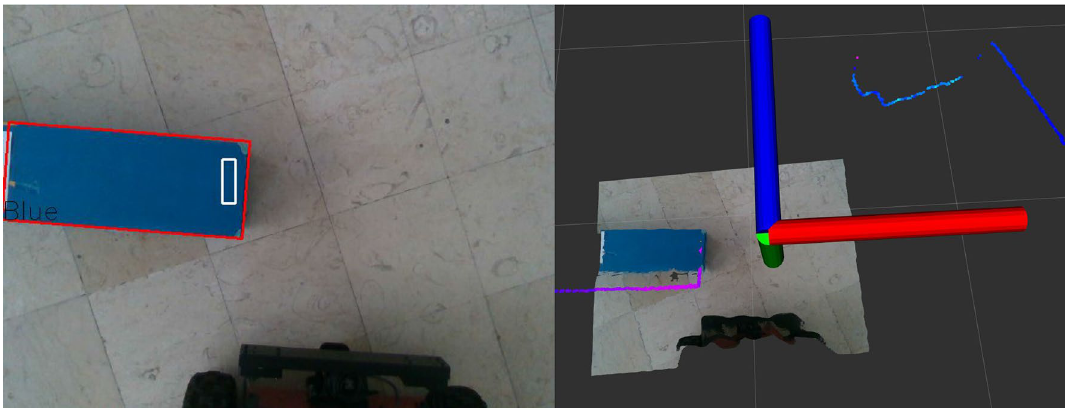
position for the edge of the reference brick. Right: A placement pose is computed relative to the reference edge that is communi- cated to the manipulator planner